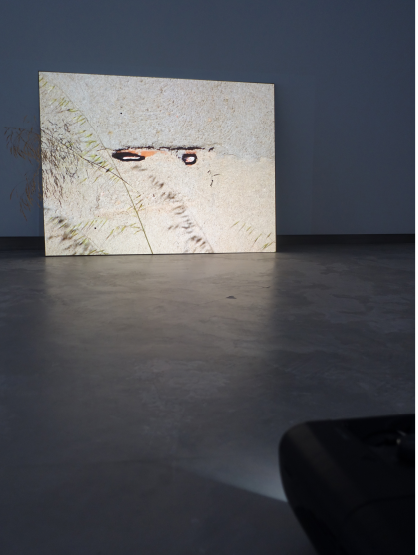
Figure 2: Video-installation IKEBANA (2016) by Alexandre